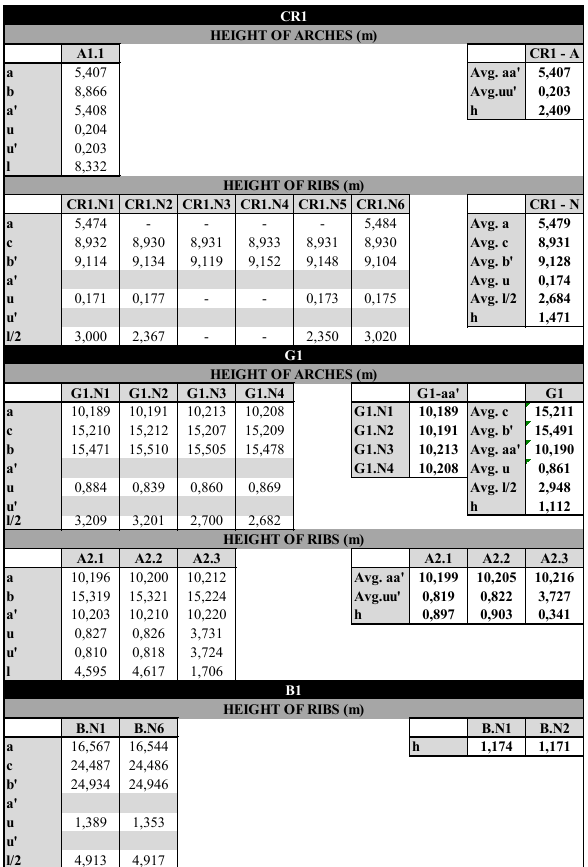
Table 1: Values of heights obtained from arches and